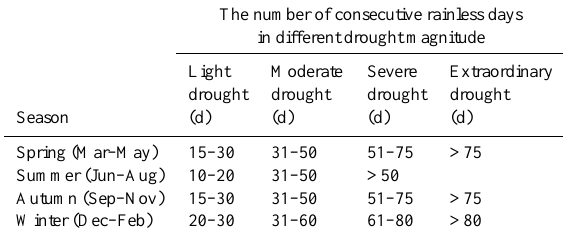
Table 4. Consecutive rainless days and drought magnitude stan-